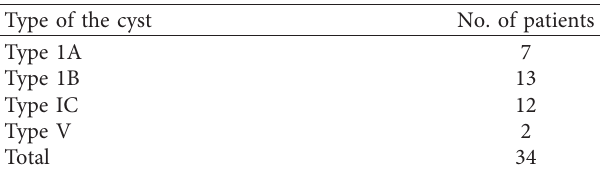
Table 2: Frequency of types of the cyst according to Todani